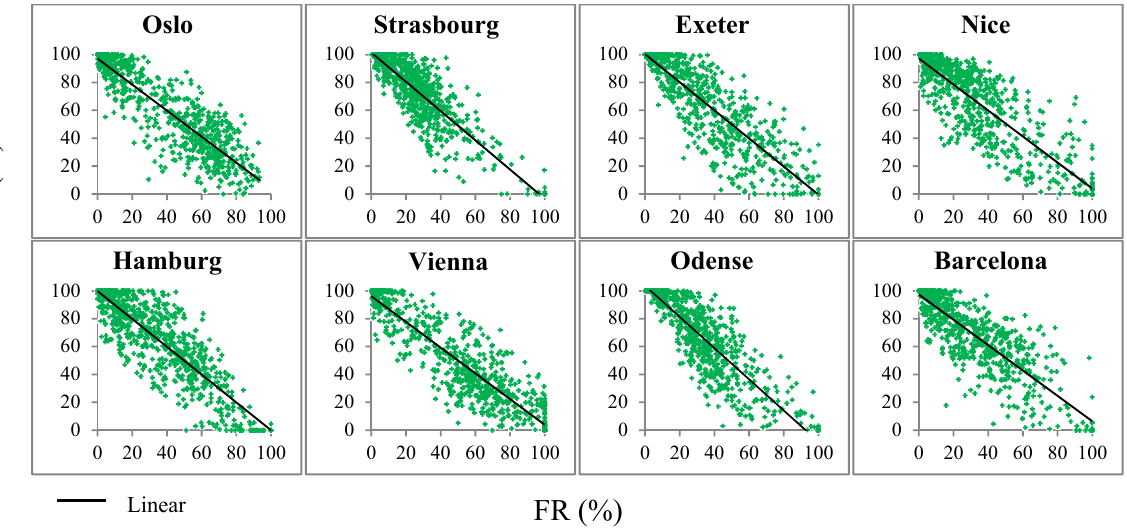
Figure 4. Relationship between reference IS fractions and NDVI/SAVI/FR for the eight urban